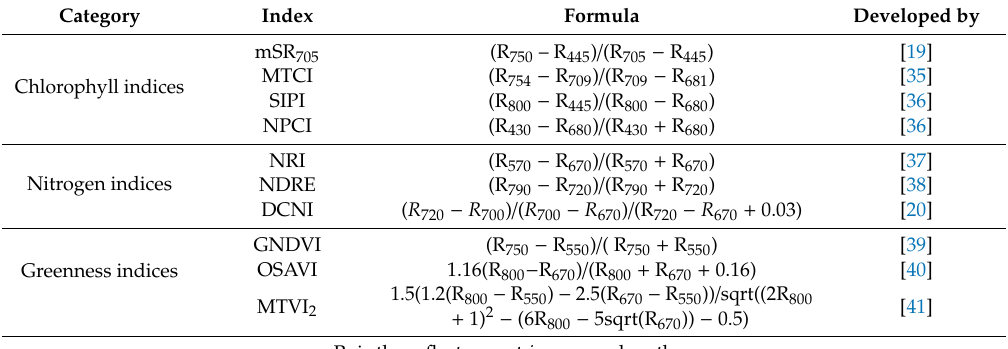
Table 1. The definitions and reference sources of narrowband spectral indices tested in this